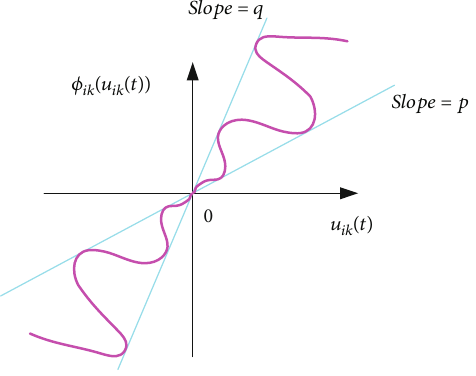
ð u ð t ÞÞ within the ik ik